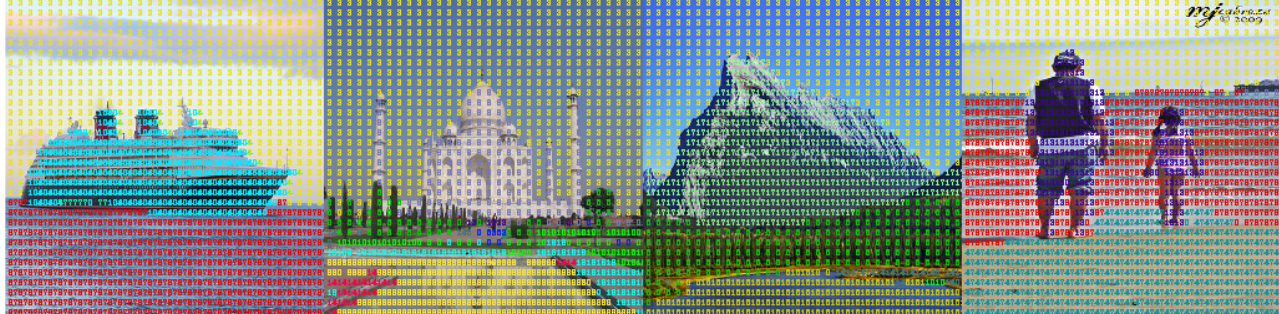
Figure 4. Examples of 2D semantic map visualization. Semantic labels are marked as numbers in different